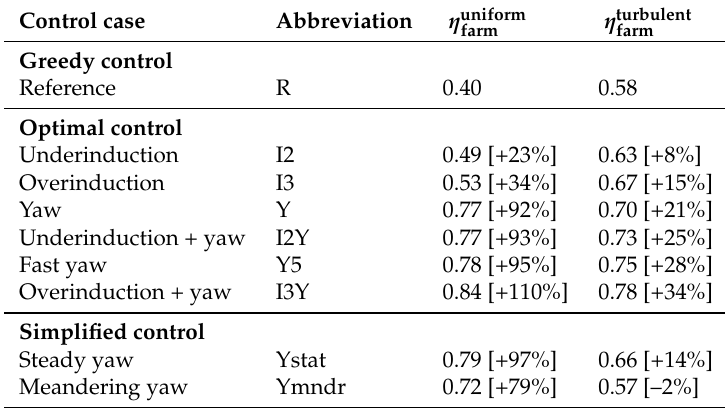
Table 2. Summary of wind-farm efficiencies and power gains. Optimal control cases are sorted based on farm